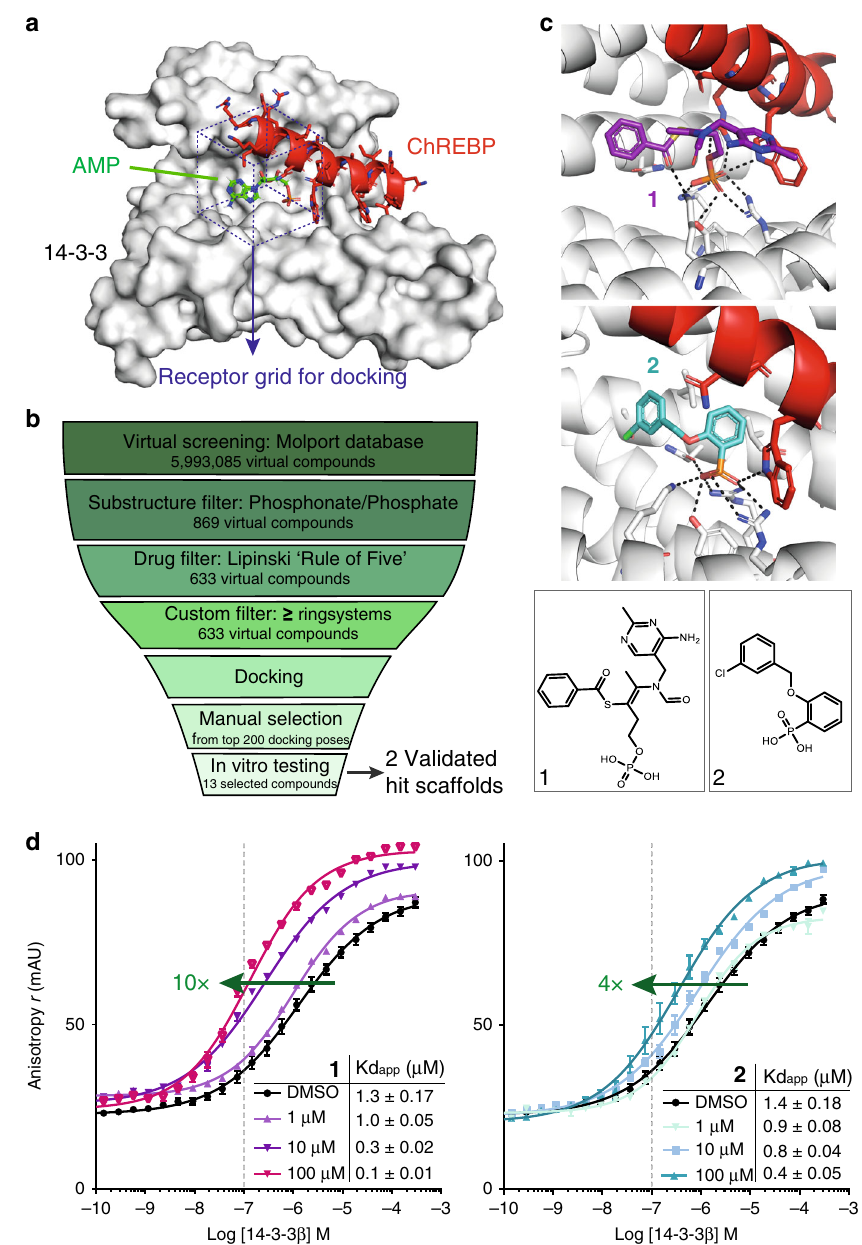
Fig. 1 A structure-based in silico screen for small-molecule stabilizers of the 14-3-3/ChREBP protein complex. a The receptor grid (purple dotted box) for docking in the crystal structure of 14-3-3 β (gray surface), ChREBP (red cartoon and sticks), and AMP (green sticks) (PDB entry 5F74) 25 . b Overview of the virtual screening procedure. c Docking poses and chemical structures of 1 and 2 . d Titration curves of 14-3-3 β on 100 nM fl uorescently-labeled ChREBP peptide in the presence of increasing concentrations (1, 10, 100 μ M) of 1 or 2 . Data and error bars represent mean ± SEM, n = 3 replicates. Source data are provided as a Source data fi